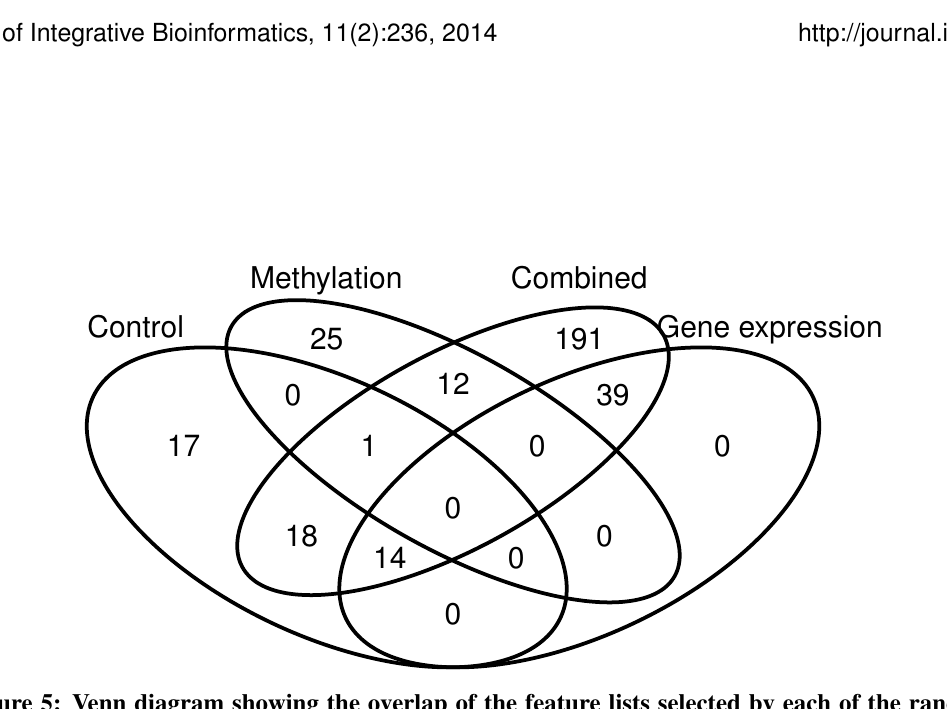
Figure 5: Venn diagram showing the overlap of the feature lists selected by each of the random forest models and the PAM50 genes that serve as gold